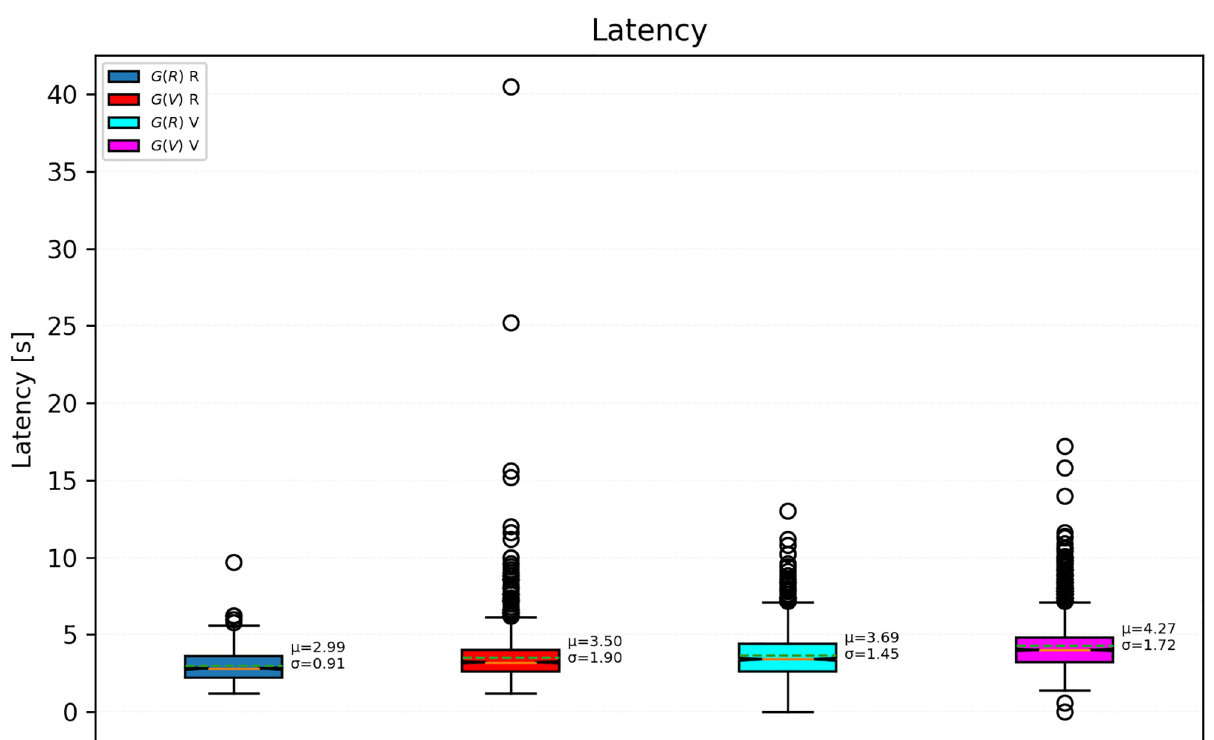
Fig 3. Response latencies by group and